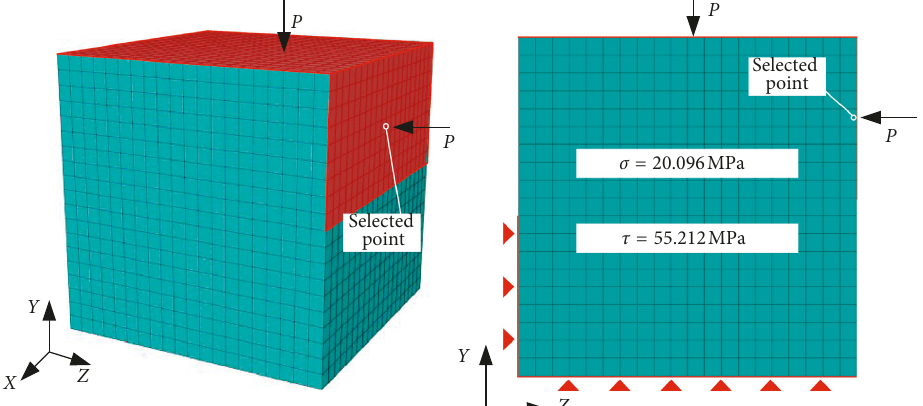
Figure 12: Three-dimensional numerical model mesh shape and boundary